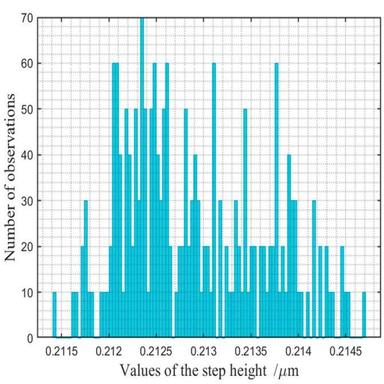
Distributions of the step height values computed by our proposed Centroid-Normal method in Experiment 3.